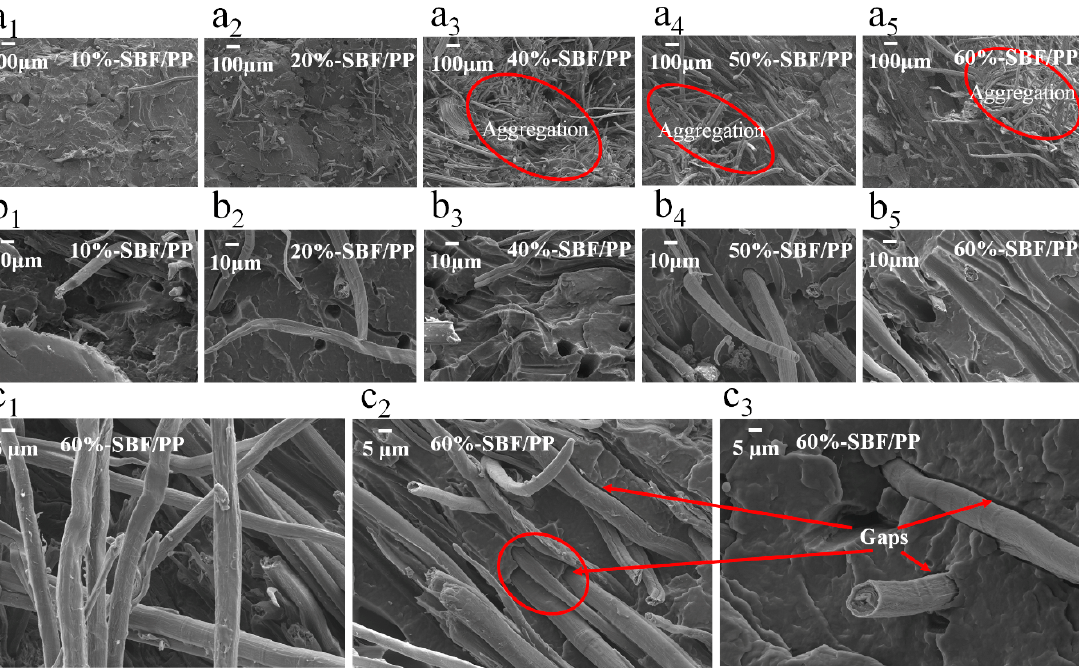
Figure 7. Photographs of the pure PP and composites after bending tests. ( a – e ) belong to the pure PP and composites with 10%–60% SBF, respectively.